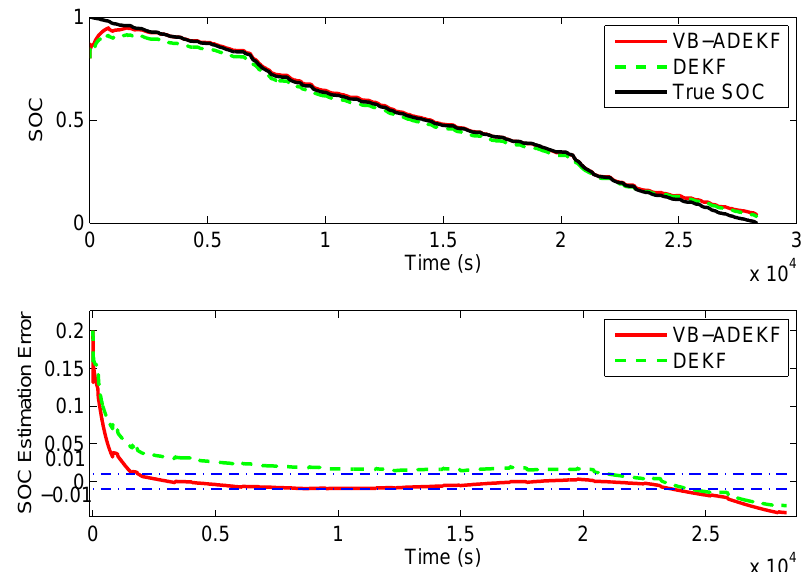
Figure 18. SOC estimation results using VB-ADEKF and DEKF in the case of mistuning in the pulse current discharge test.